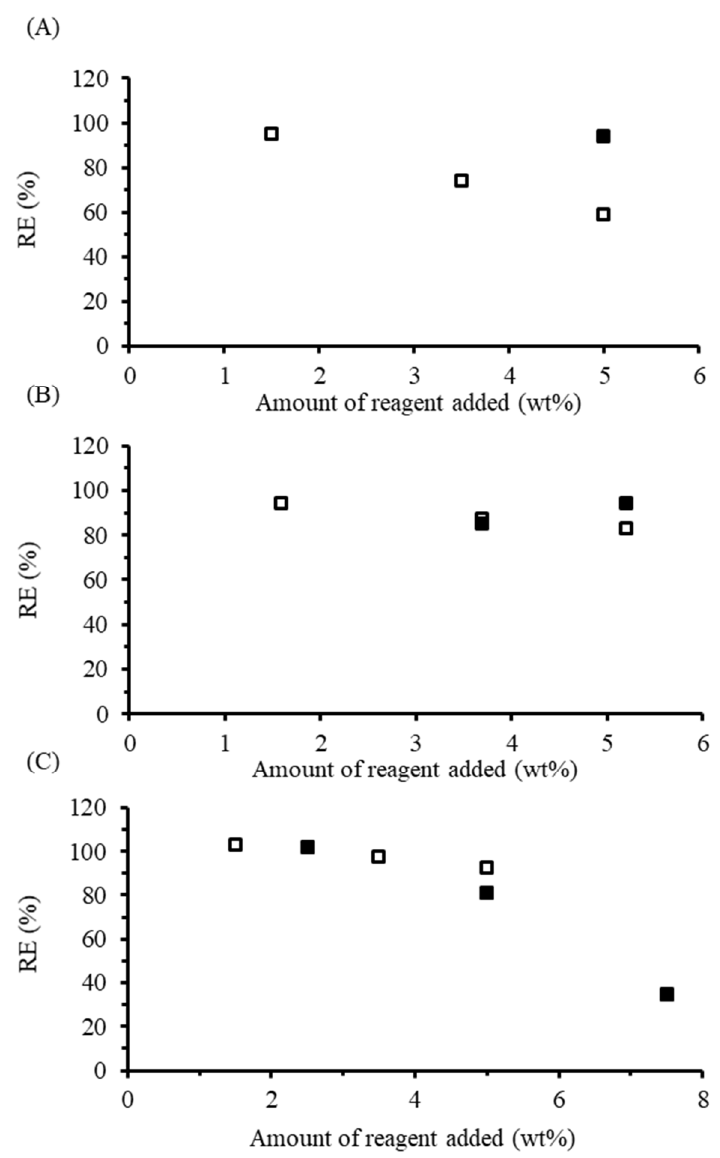
Figure 8. Modification of starch in a pilot plant twin-screw extruder ( □ ) without base and ( ■ ) with 1.1 equiv of NaOH and ( A ) DDSA, ( B ) TENAX 2010, and ( C ) MSO-1.1. 1.1 equiv of NaOH and ( A ) DDSA, ( B ) TENAX 2010, and ( C )